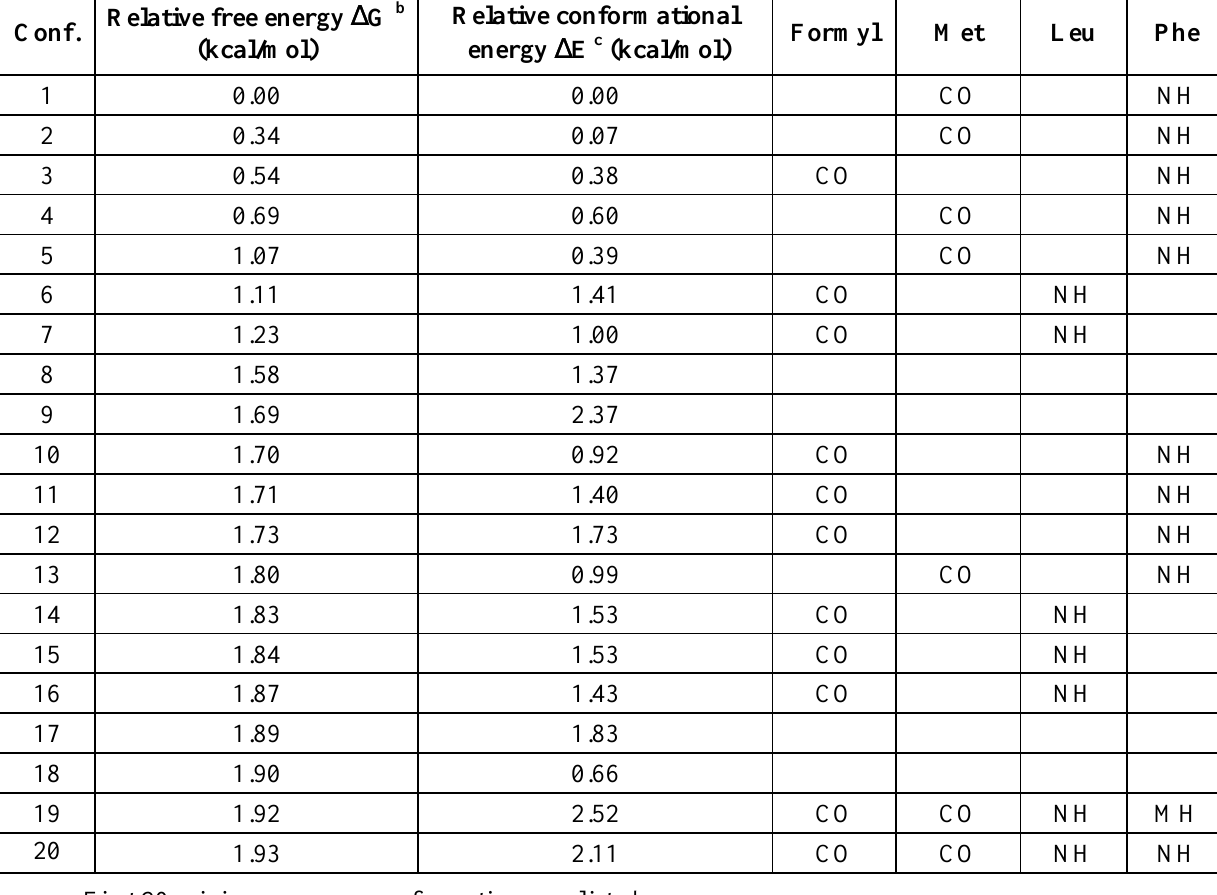
Table 1. Conformational characteristics of formyl-Met-Leu-Phe-OMe a .